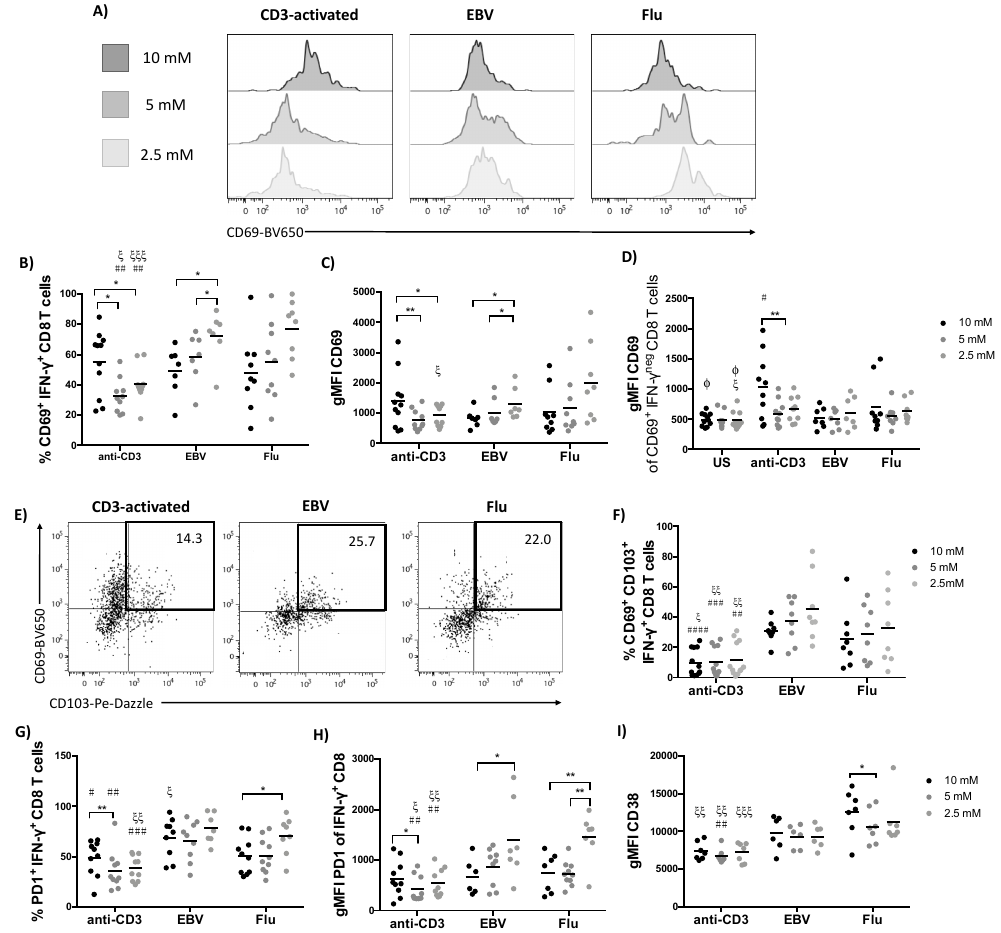
Figure 4. Glucose restriction induces markers of residency in virus-specific T cells. Activation-related markers were assessed in IFN- γ + CD8 T cells on day 7 post restimulation. ( A ) Representative histogram of CD69 expression in IFN- γ + CD8 T cells. ( B ) Percentage and ( C ) gMFI of CD69 in IFN- γ + and ( D ) in IFN- γ neg CD8 T cells. ( E ) Representative dot plot showing CD103 and CD69 expression in IFN- γ + CD8 T cells after stimulation in media containing 10 mM of glucose. ( F ) Percentage of CD69 + CD103 + double positive IFN- γ + CD8 T cells. ( G ) Percentage and (H ) gMFI of coinhibitory PD1. ( I ) Expression level of the activation marker CD38. Mann–Whitney test when comparing between the same concentration of glucose in different groups, Φ p < 0.05 when comparing with CD3-stimulated, ξ p < 0.05, ξξ p < 0.01, ξξξ p < 0.001 when comparing with flu-stimulated group and # p < 0.05, ## p < 0.01, ### p < 0.001, #### p < 0.0001 when comparing with EBV-stimulated group. Wilcoxon paired t test when comparing between glucose concentrations within the same group, * p < 0.05, ** p < 0.01.